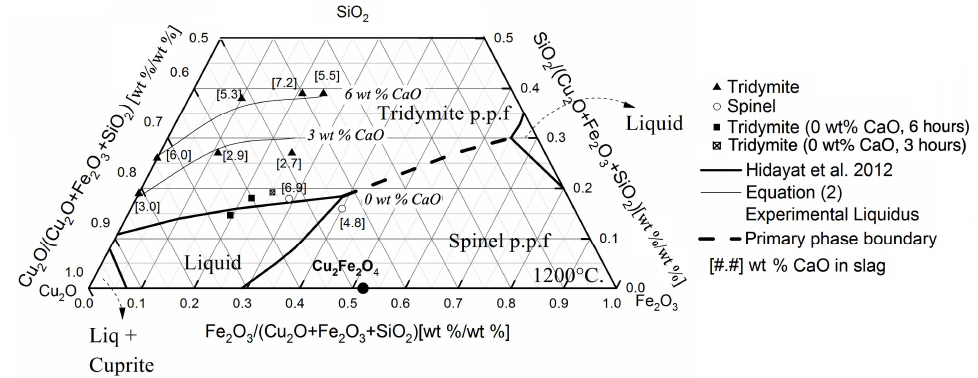
Figure 10. Liquidus for the equilibrium slag / tridymite of the Cu 2 O–Fe 2 O 3 –SiO 2 system with additions of CaO at 1200 ◦ C, in equilibrium with metallic